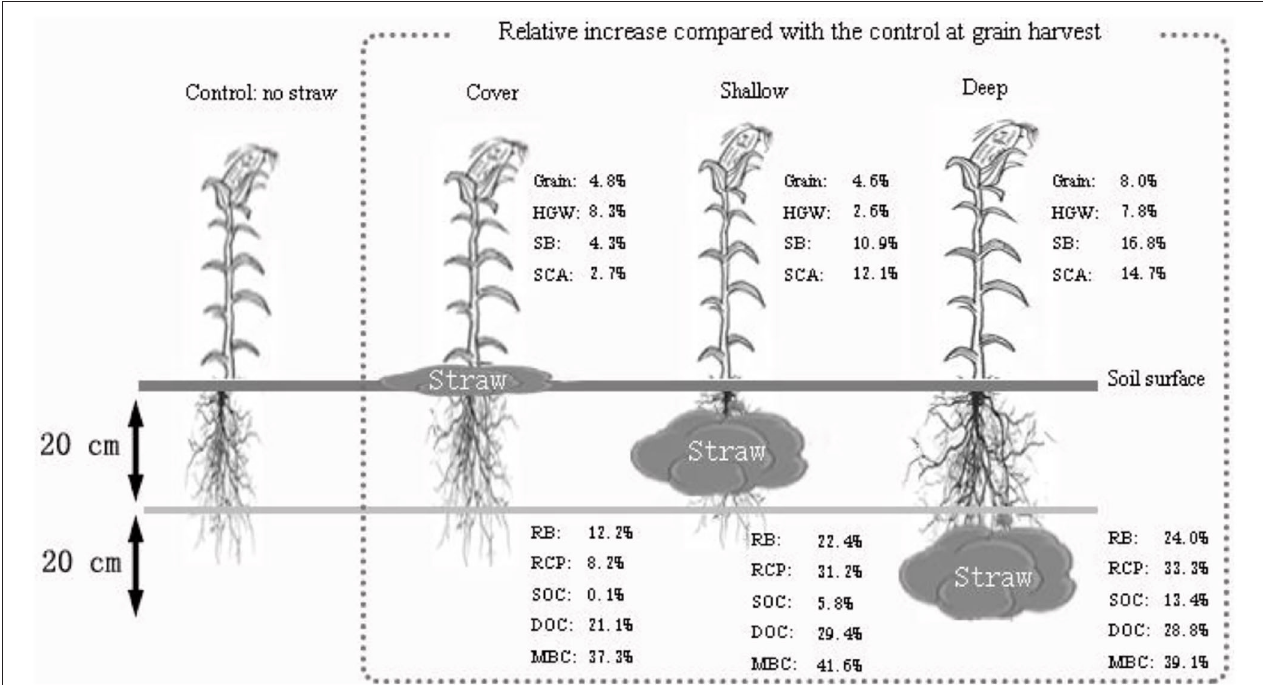
FIGURE 5 | Relative increase in various parameters at maize harvest in the three treatments with straw addition compared with the treatment without straw. Control, no straw added; Cover, straw added to the soil surface; Shallow, straw incorporated at the 0–20cm soil depth; Deep, straw incorporated at the 20–40cm soil depth. HGW, 100-grain weight; SB, shoot biomass; RB, root biomass; SCA, shoot carbon assimilation; RCP, root carbon partitioning; SOC, soil organic carbon; DOC, dissolved organic carbon; MBC, microbial biomass